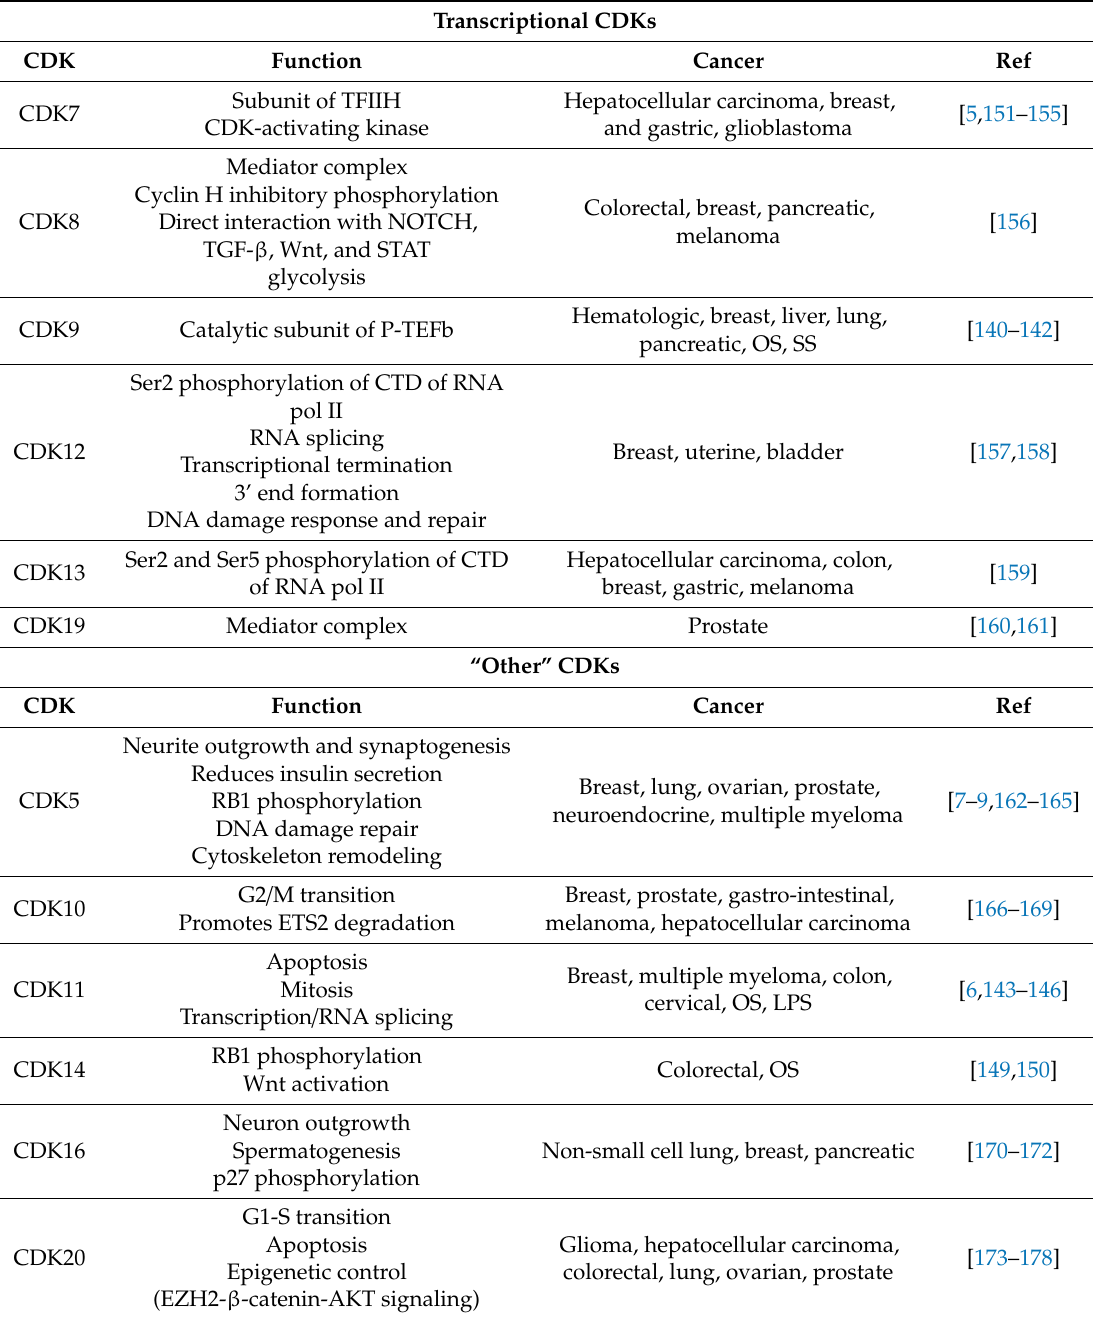
Table 2. Function and implications in human cancers of non-canonical